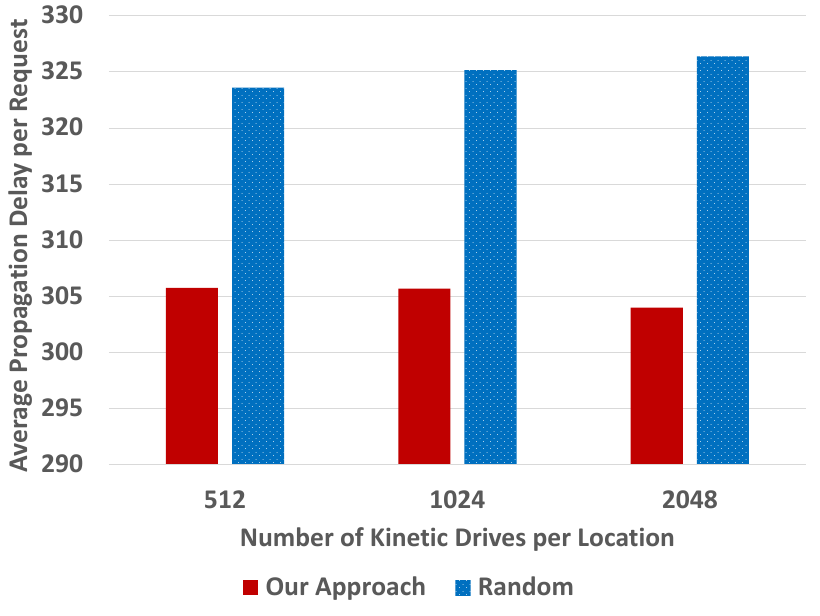
Figure 8. Average propagation delay per request (normalized): 16 regions, 1000 users.